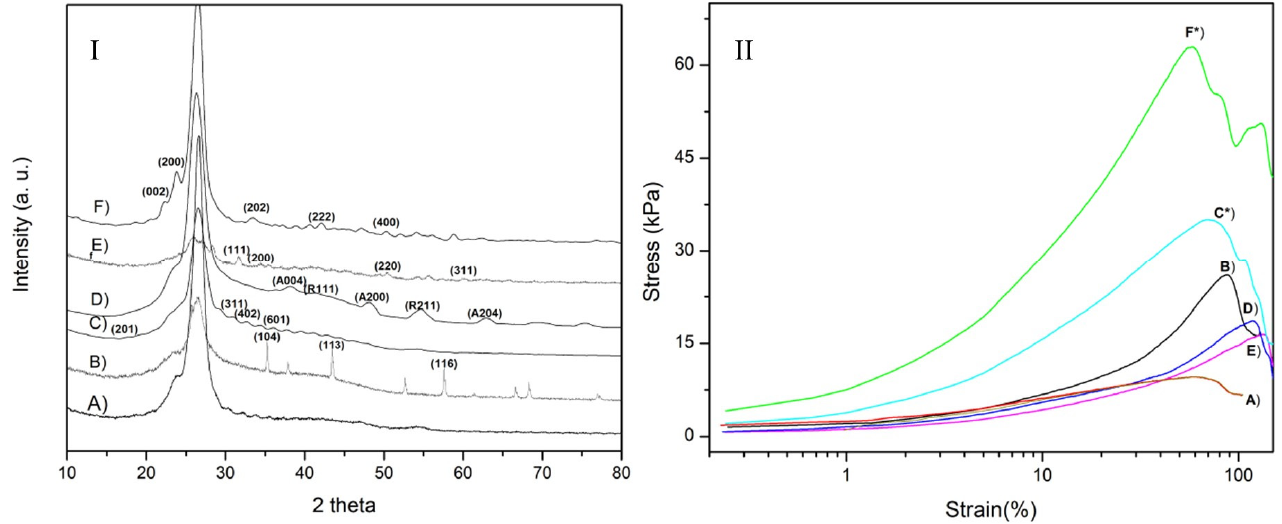
Figure 1. ( I ) XRD Alginate-gelatin hydrogels (A) AG1 (control); (B) AG2 (Al 2 O 3 ); (C) AG3 (Na 2 Ti 6 O 13 ); (D) AG4 (TiO 2 ); (E) AG5 (ZrO 2 ); and (F) AG6 (WO 3 ); ( II ) Mechanical assays of alginate-gelatin samples (A) AG1 (control); (B) AG2 (Al 2 O 3 ); (C) AG3* (Na 2 Ti 6 O 13 ); (D) AG4 (TiO 2 ); (E) AG5 (ZrO 2 ); and (F) AG6* (WO 3 ).